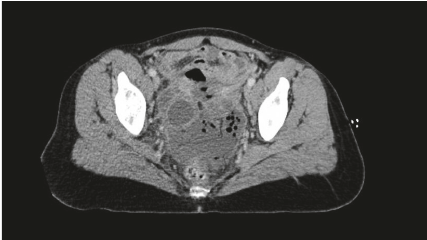
Figure 2: Axial CT image demonstrating abscess at vaginal